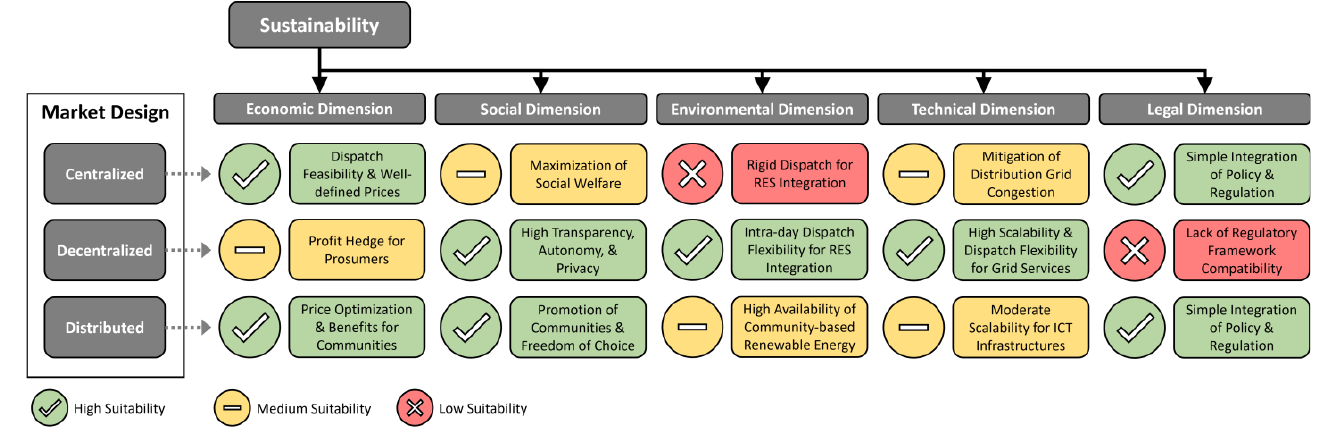
Figure 8. Diagram of the suitability of centralized, decentralized, and distributed market designs for the economic, social, environmental, technical, and legal dimensions of sustainability.